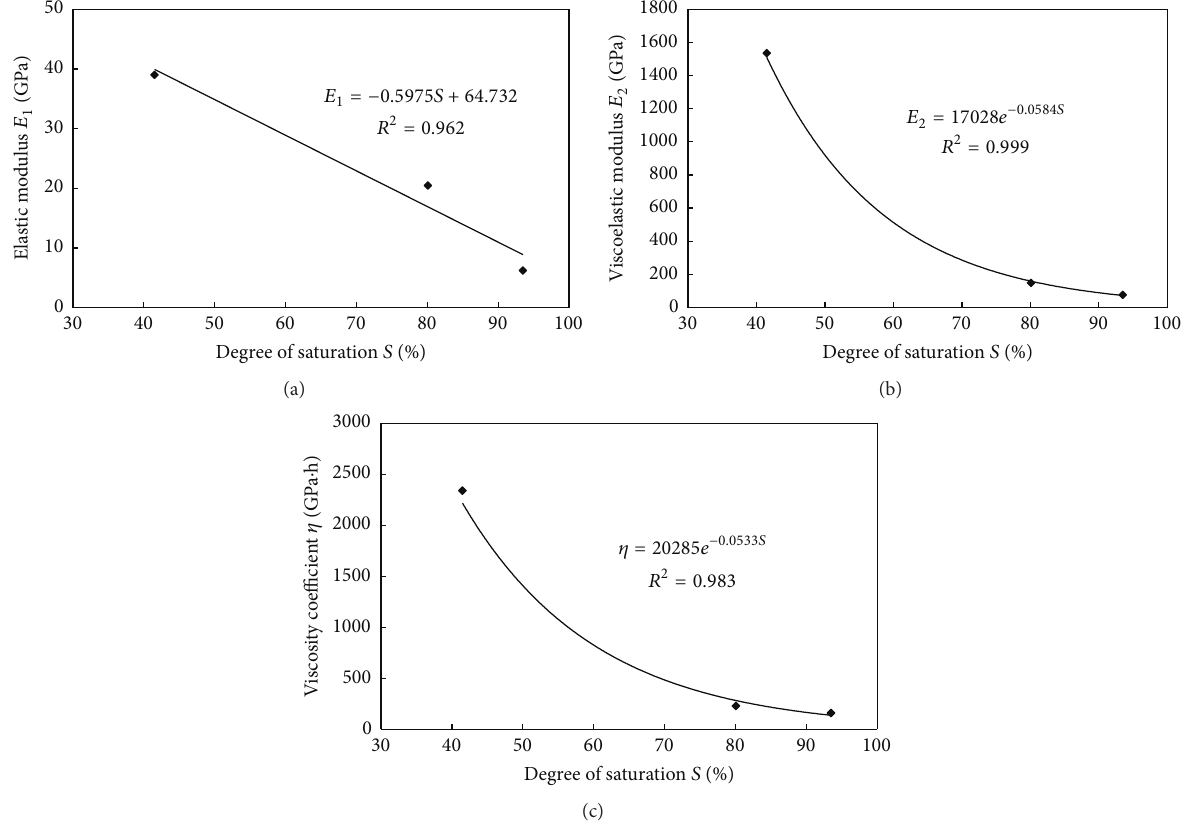
Figure 7: Parameters of generalized Kelvin model with the degrees of saturation: (a) 𝐸 1 - 𝑆 ; (b) 𝐸 2 - 𝑆 ; (c) 𝜂 - 𝑆